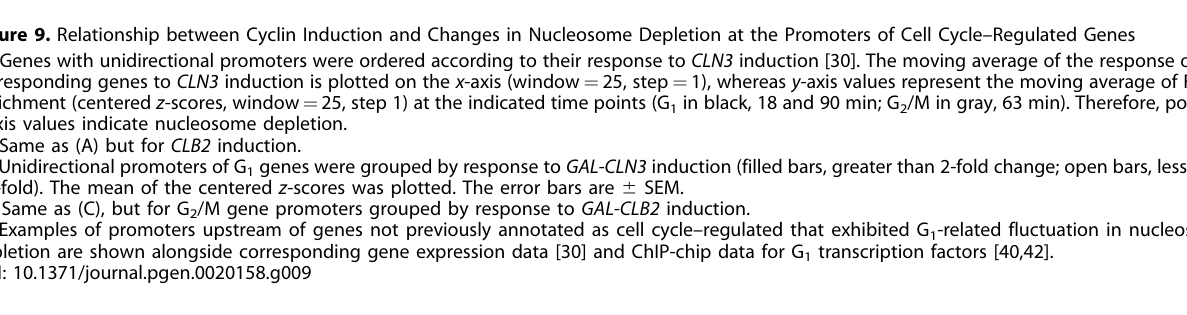
Figure 9. Relationship between Cyclin Induction and Changes in Nucleosome Depletion at the Promoters of Cell Cycle–Regulated Genes (A) Genes with unidirectional promoters were ordered according to their response to CLN3 induction [30]. The moving average of the response of the corresponding genes to CLN3 induction is plotted on the x -axis (window ¼ 25, step ¼ 1), whereas y -axis values represent the moving average of FAIRE enrichment (centered z -scores, window ¼ 25, step 1) at the indicated time points (G 1 in black, 18 and 90 min; G 2 /M in gray, 63 min). Therefore, positive y -axis values indicate nucleosome depletion. (B) Same as (A) but for CLB2 induction. (C) Unidirectional promoters of G 1 genes were grouped by response to GAL-CLN3 induction (filled bars, greater than 2-fold change; open bars, less than 1.5-fold). The mean of the centered z -scores was plotted. The error bars are 6 SEM. (D) Same as (C), but for G 2 /M gene promoters grouped by response to GAL-CLB2 induction. (E) Examples of promoters upstream of genes not previously annotated as cell cycle–regulated that exhibited G 1 -related fluctuation in nucleosome depletion are shown alongside corresponding gene expression data [30] and ChIP-chip data for G 1 transcription factors [40,42]. DOI: